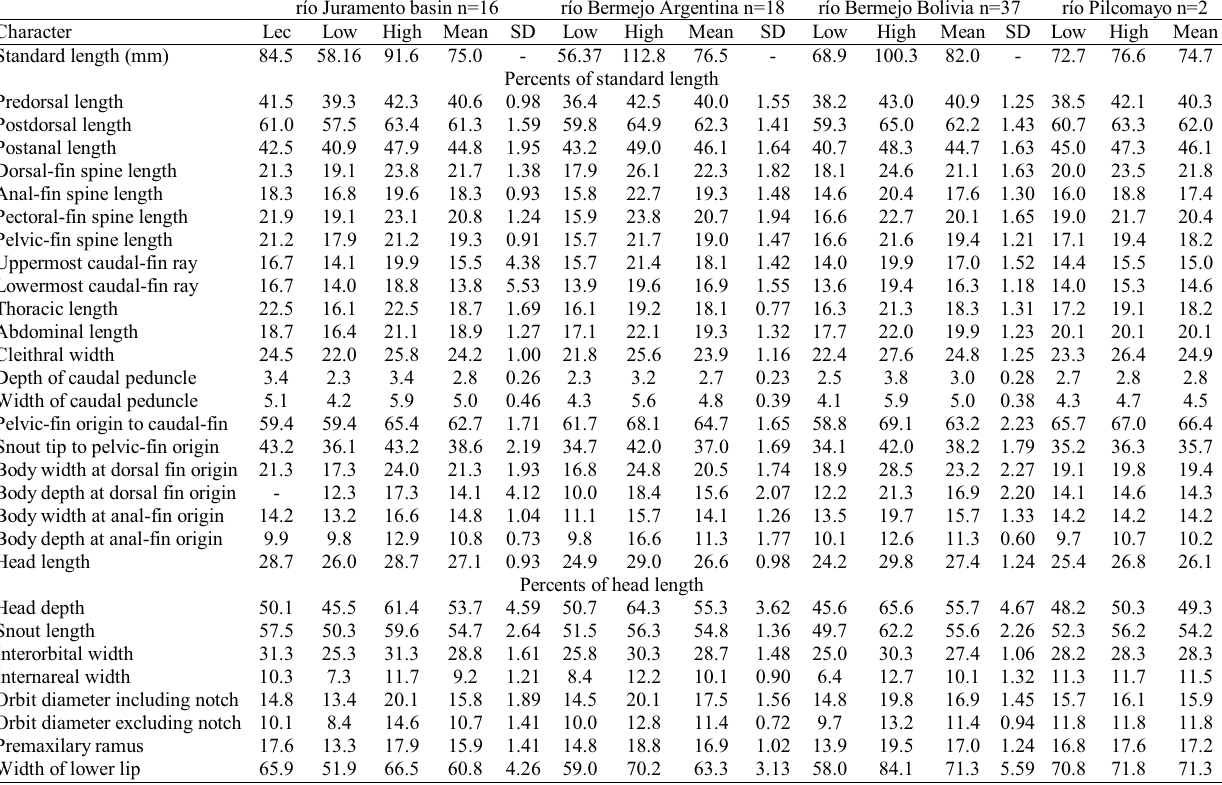
Table 1. Descriptive morphometrics of Ixinandria steinbachi of four distinct populations. Values are given as percents of standard length or of head length. Lec = Lectotype of Loricaria steinbachi , SD = standard